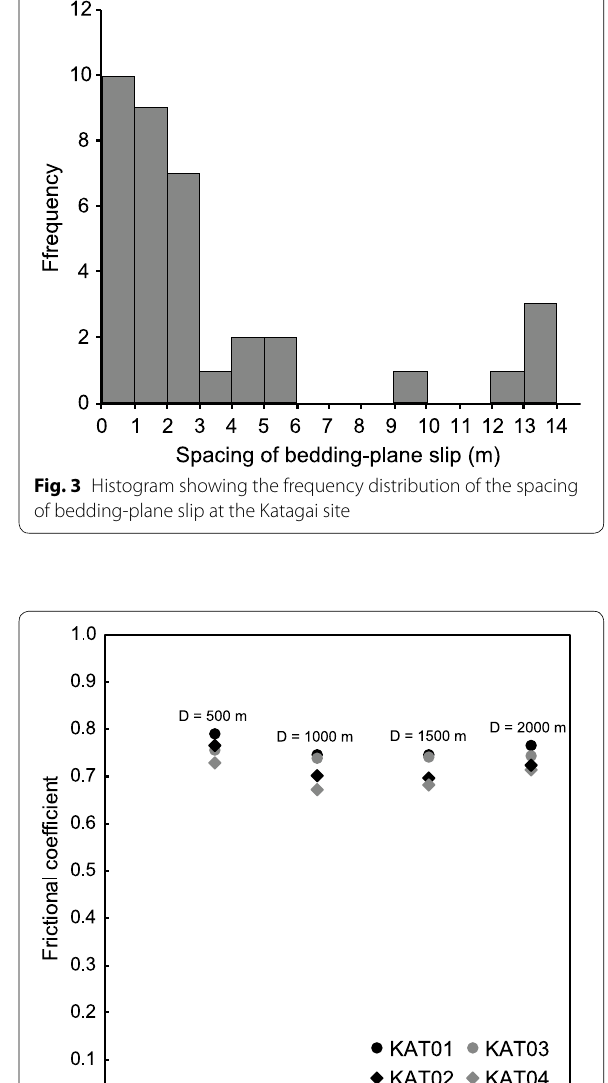
times at each normal stress to achieve a steady-state fric- tion. These normal stresses correspond to shallow crustal depths of 0.5, 1.0, 1.5, and 2.0 km, respectively (density of the Uonuma Formation 2360 kg/m 3 ; Hoshino et al. = 2001).